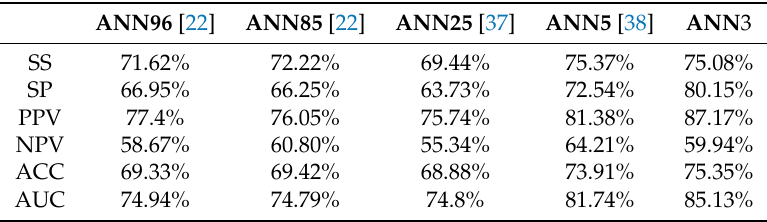
Table 13. Performance indicator versus technique using random subsampling validation with HMS